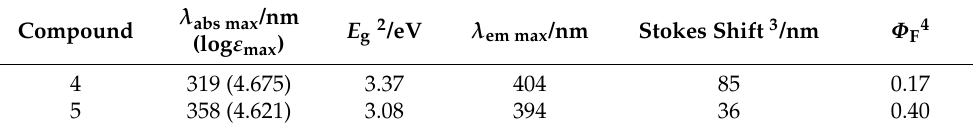
Table 1. Photophysical properties 1 of bis-calixarene-carbazole conjugates.